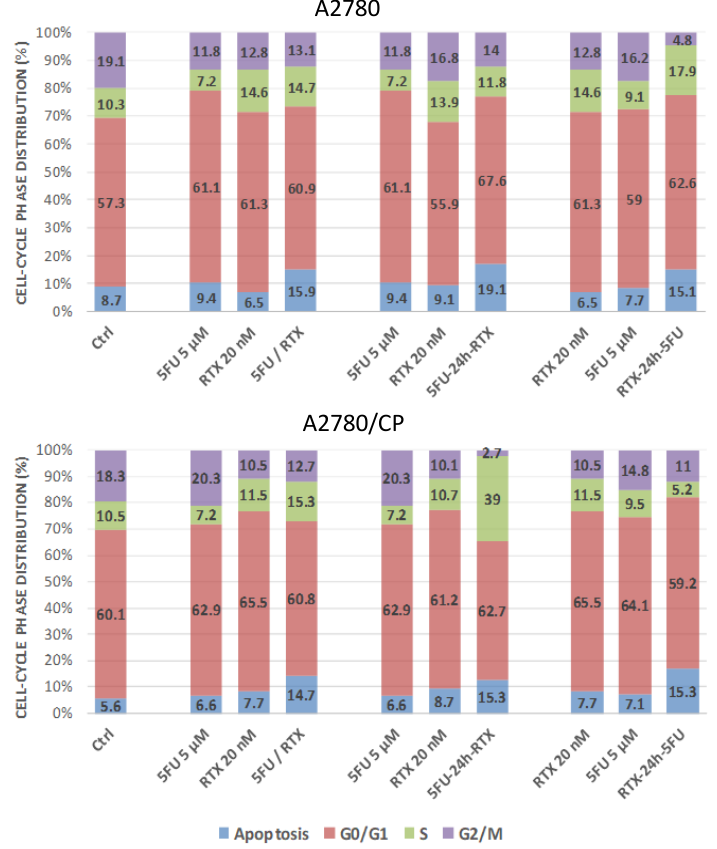
Figure 8. Cell cycle phase distribution percentages in cisplatin sensitive (A2780, upper panel) and resistant (A2780/CP, bottom panel) cancer cells treated with 5FU-RTX combinations with different combination patterns. Cell cycle phase distributions of A2780 and A2780/CP cells were determined by cytofluorimetric analysis of the PI-stained DNA content. Cells were exposed to 20 nM RTX, 5 μM 5FU alone, or with their combinations according to three schedules: simultaneous treatment (5FU/RTX) (left columns), 5FU first, RTX 24 h later (5FU-24h-RTX) (middle columns), and the opposite (RTX-24h-5FU) (right columns). Cells were treated with concentrations of each drug corresponding to 1:250 RTX:5FU ratio. Inserted numbers indicate the percentage of cells in the different phases of the cell cycle. The values are the mean of two/three experiments.